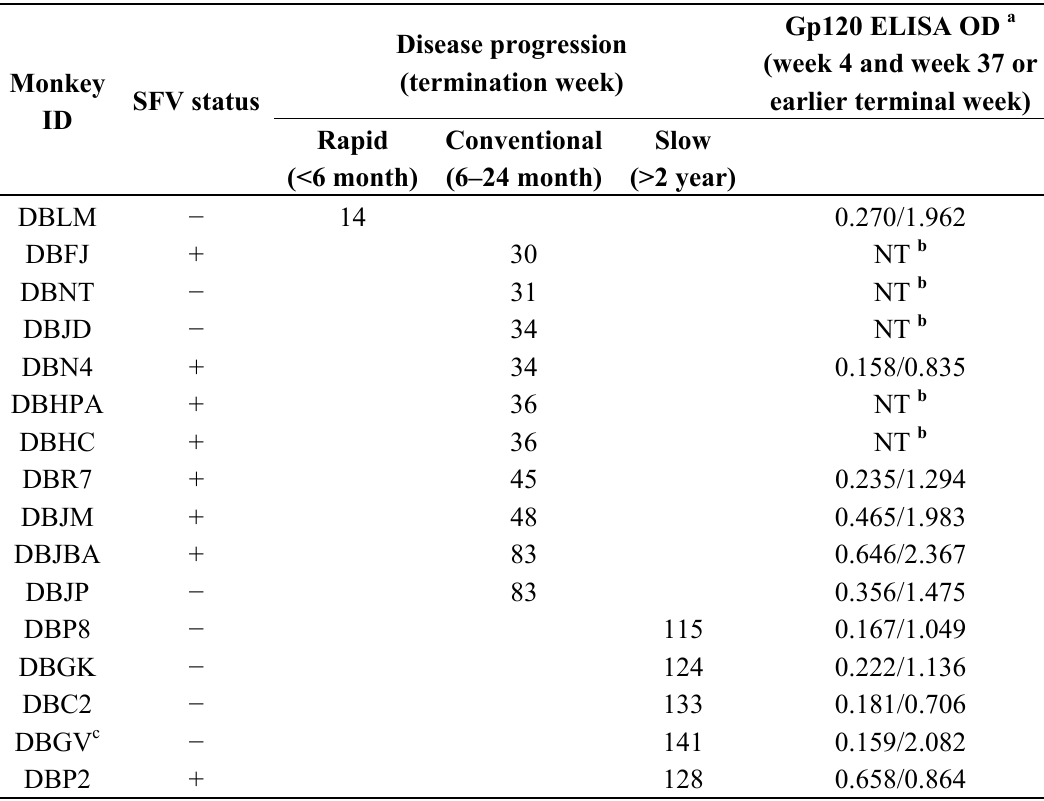
Table 1. SIV groups based upon disease progression. Monkeys were grouped based upon rapid, conventional, or slow disease progression. The SFV status and the gp120 ELISA OD are also